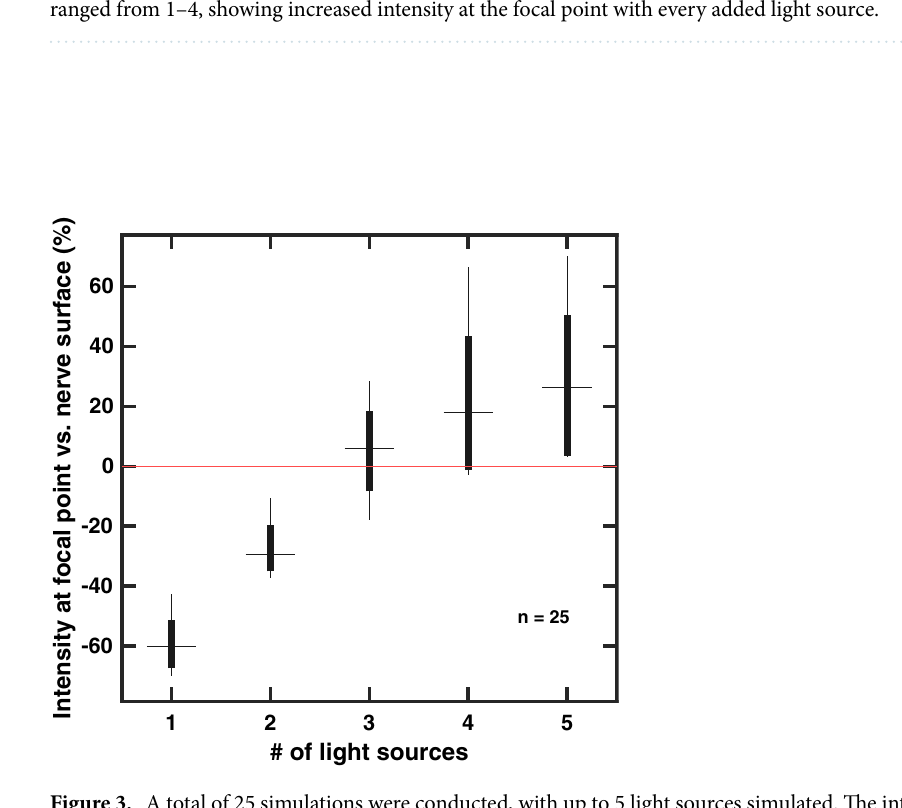
Figure 2. For each 3D simulation environment was summed into a cross-sectional matrix representing a 0.6 mm segment of nerve. The figure shows a simulation of a 1 mm diameter nerve and the change in maximum photon intensity moving from the nerve surface to the center, focal point in a radial manner. Maximum intensity is normalized where the intensity near the nerve surface is 1. The number of light sources simulated ranged from 1–4, showing increased intensity at the focal point with every added light source.